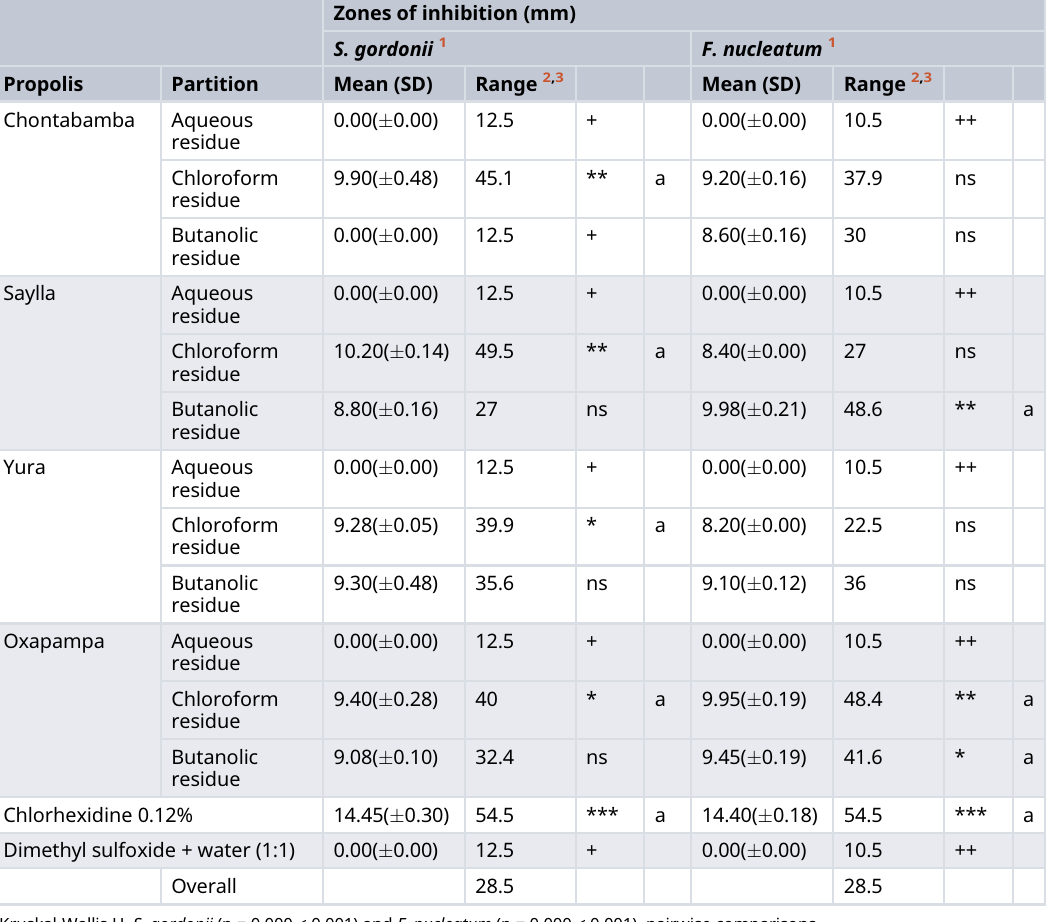
midrange; ns: not significant. 3 Dunn test for multiple comparisons, where the same letter indicates no difference between treatments exceeding the average.